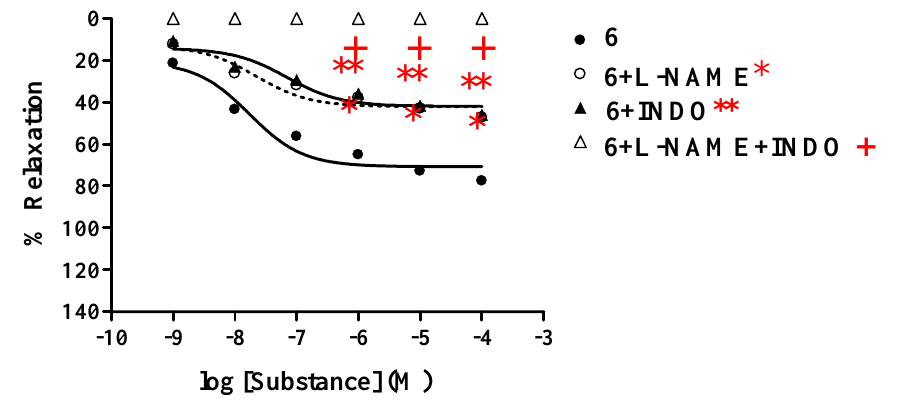
Figure 7. Effect of 6 on the vascular function of rat thoracic aorta in the presence of INDO compared with L -NAME and with L -NAME plus